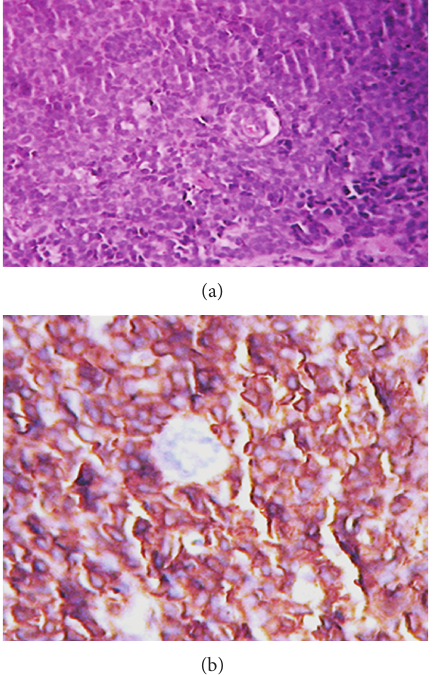
Figure 2: Sheets of small round cells. Hematein-eosin stain × 40 (a); CD99 membranous staining of tumor cells × 40